Question: Write a single sentence explaining what this figure depicts.
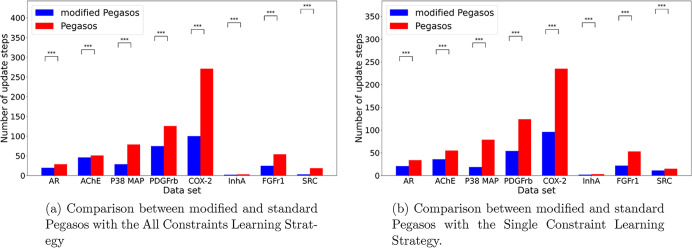
Answer: Bar plot showing the mean number of update steps required to train the models to achieve an Adjusted Rand Index of 0.95, averaged over 1000 repetitions. For each data set, the red bars represent the standard Pegasos algorithm and the blue bars represent the modified version. The number of update steps refers to the number of times the models were updated. Significance brackets indicate the significance of the differences of the number of learning steps of the modified and the standard Pegasos algorithm (paired sample t -test) with *** indicating an uncorrected p-value <0.001.